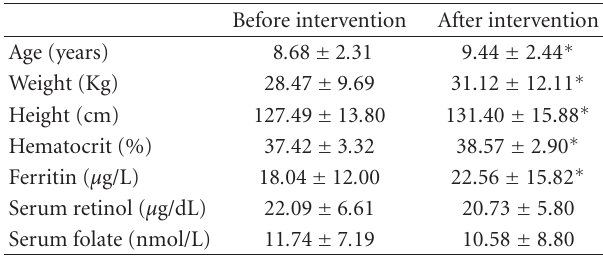
Table 1: Changes in anthropometric and hematological parameters in children before and after the intervention of nutritional educa- tion in schools from Aragua, T´achira, and Lara States, Venezuela. ( n = 427).